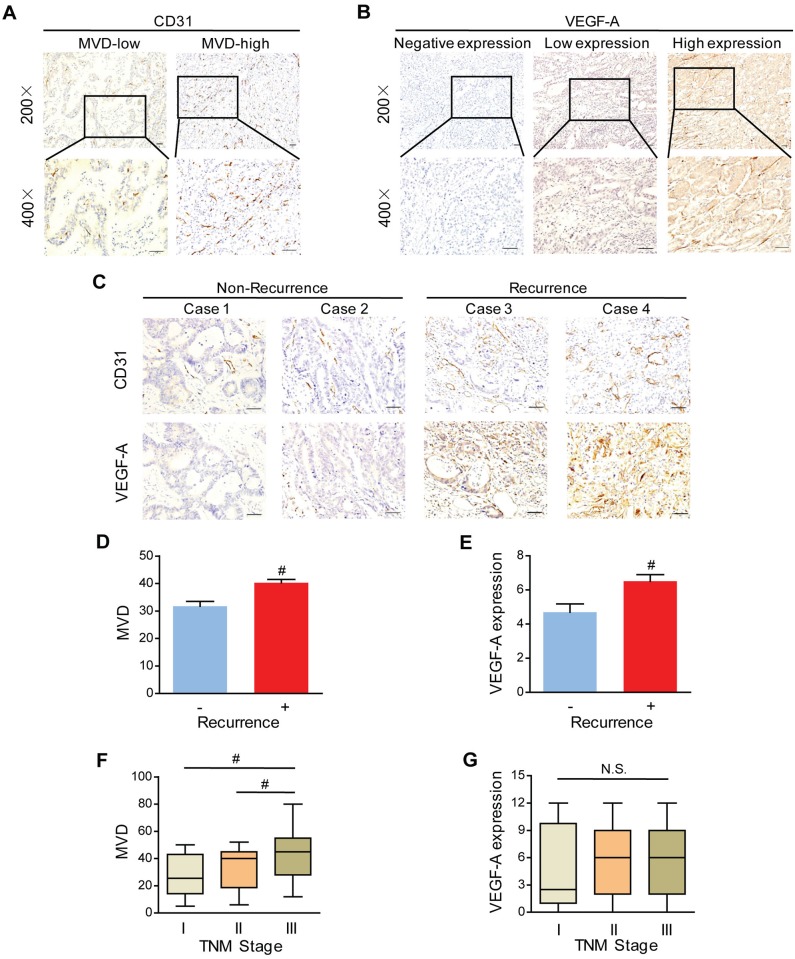
Microvessel density (MVD) and vascular endothelial growth factor A (VEGF-A) positively correlate with the recurrence.(A) Representative immunostaining of CD31 in GC tissues. (B) Representative pictures of VEGF-A stained in human GC tissues. (C-E) Representative photomicrographs (C) and Bar graph showing MVD (D) and VEGF-A expression (E) were higher in recurrence GC patients than in non-recurrence GC patients. Scale bar = 50 μm. #P < 0.01, n = 65 and n = 94 for non-recurrence and recurrence patients, respectively. (F&G) In Stage I patients, MVD was lower (F) and average VEGF-A scores tended to be lower (G) than in Stage II and Stage III. #P < 0.01 versus the corresponding control group, N.S., No significance; n = 26, n = 50 and n = 83 for Stage I, II, and III, respectively.